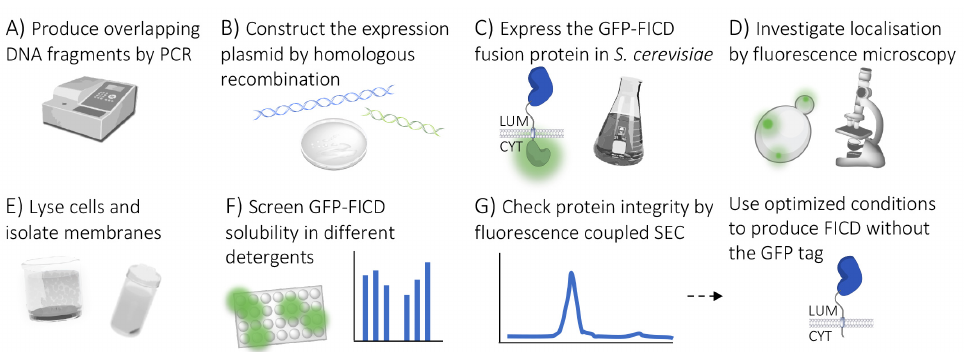
Figure 2. Workflow for screening GFP-FICD expression and purification conditions. ( A , B ) The expression vector was constructed from overlapping DNA fragments using homologous recombination in S. cerevisiae . ( C ) PAP1500 expression system was used to express GFP-tagged FICD, ( D ) and membrane insertion was checked by fluorescence microscopy. ( E ) Cells were subsequently homogenised and the membranes isolated. ( F ) GFP fluorescence was used to quantify solubilisation efficiency and identify the best detergents. ( G ) Homogeneity of solubilised FICD was determined using fluorescence-coupled size exclusion chromatography (FSEC). LUM; ER lumen, CYT; cytosol.